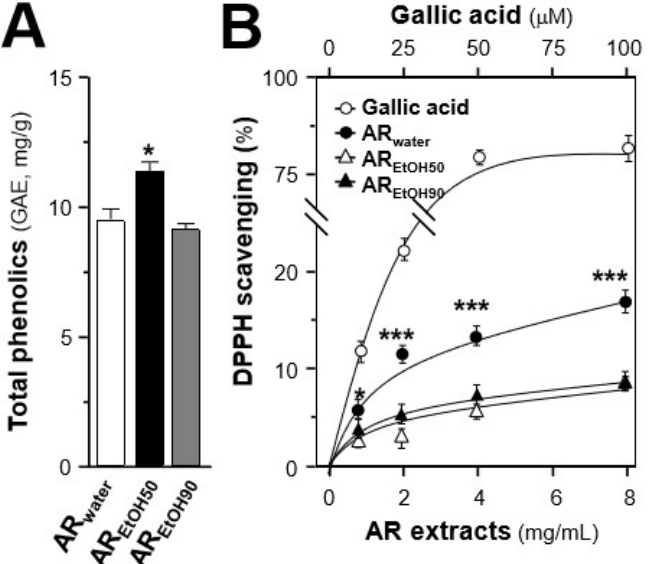
Figure 2. Comparison of total phenolic contents and 1,1-Diphenyl-2-picrylhydrazyl radical 2,2-Diphenyl- 1-(2,4,6-trinitrophenyl)hydrazyl (DPPH) radical scavenging activity of different AR extracts. ( A ) The